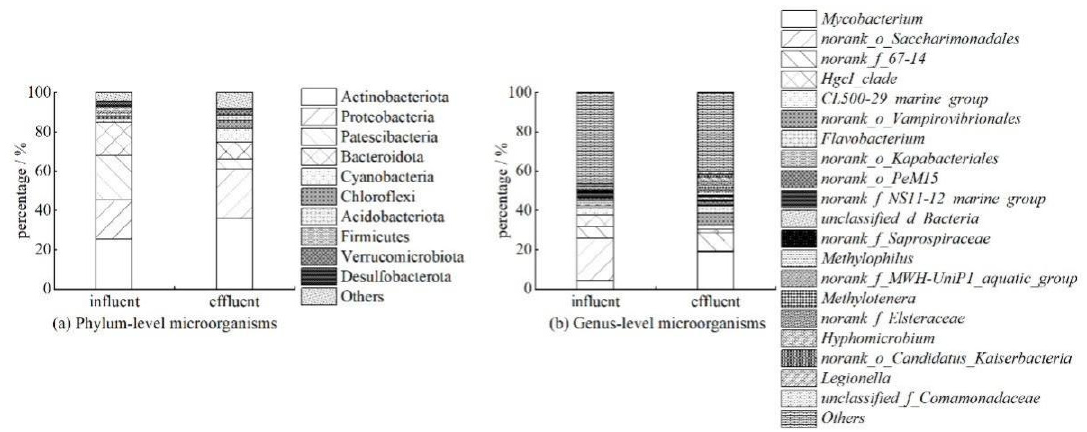
Figure 5. Microbial community structure in the influent and effluent of the device.